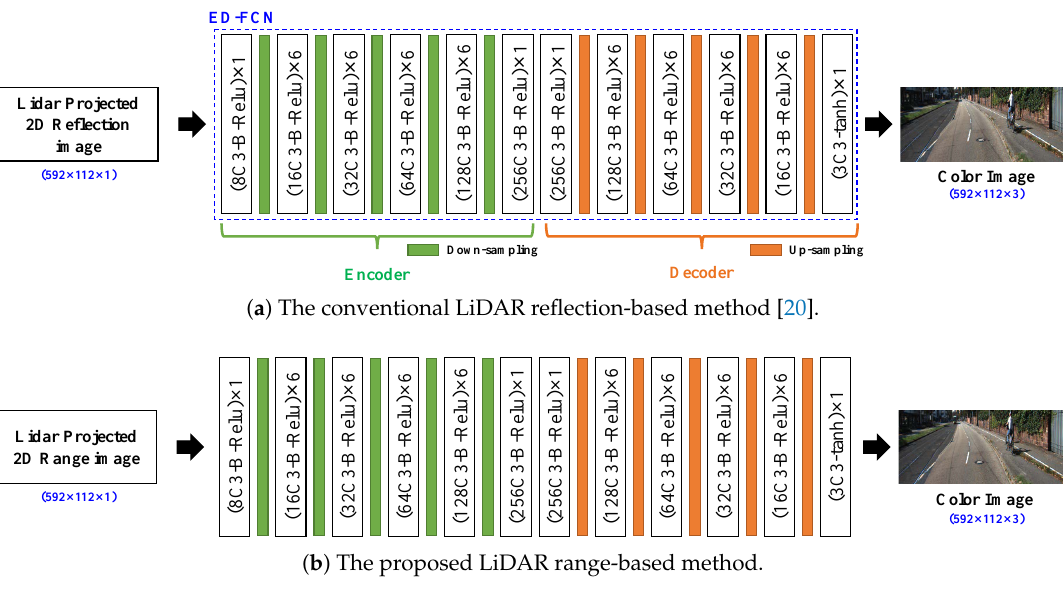
Figure 2. The color camera-captured-like image generation methods using 2D projected ( a ) reflection and ( b ) range